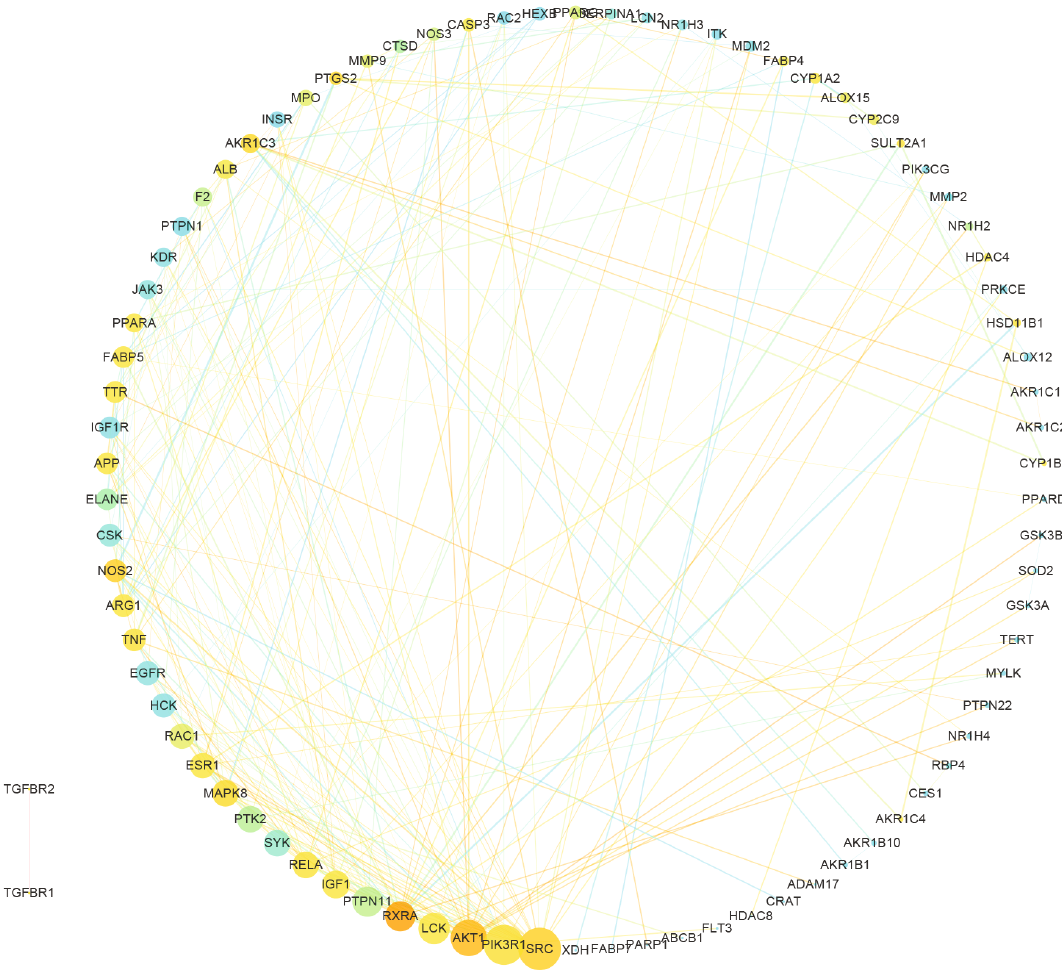
Figure 3: Visualization of the protein-protein interaction (PPI) using STRING and